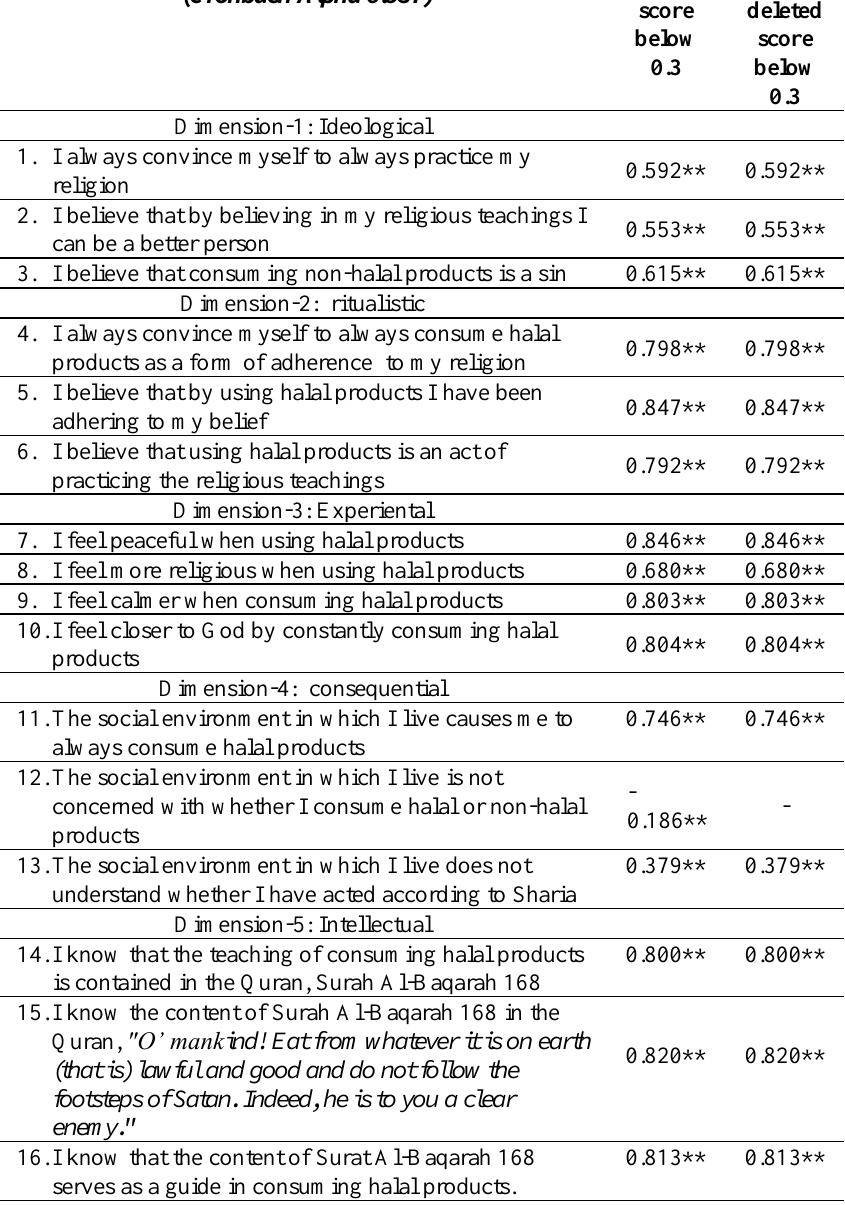
Table 3 The results of validity test: Religiosity variable Dimensions and indicators of religiosity variable (Cronbach Alpha 0.937)